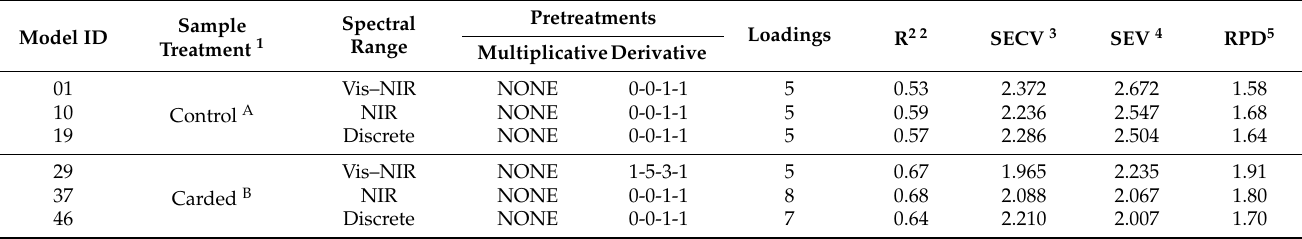
Table 2. Statistical variables of MDF prediction models in llama fibre